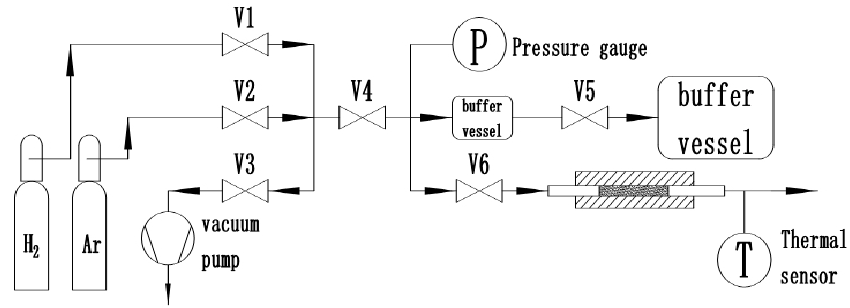
Figure 10. Hydrogen absorption and desorption performance measurement system based on Sieverts’ method.